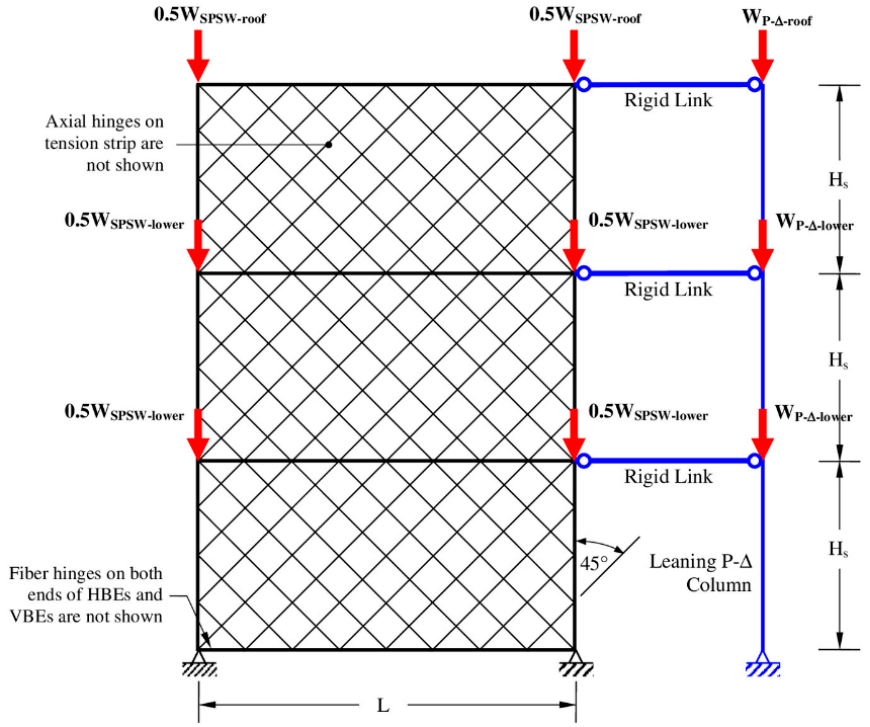
Figure 5. Nonlinear model for collapse simulation [27]; example structural model of a three-story archetype.